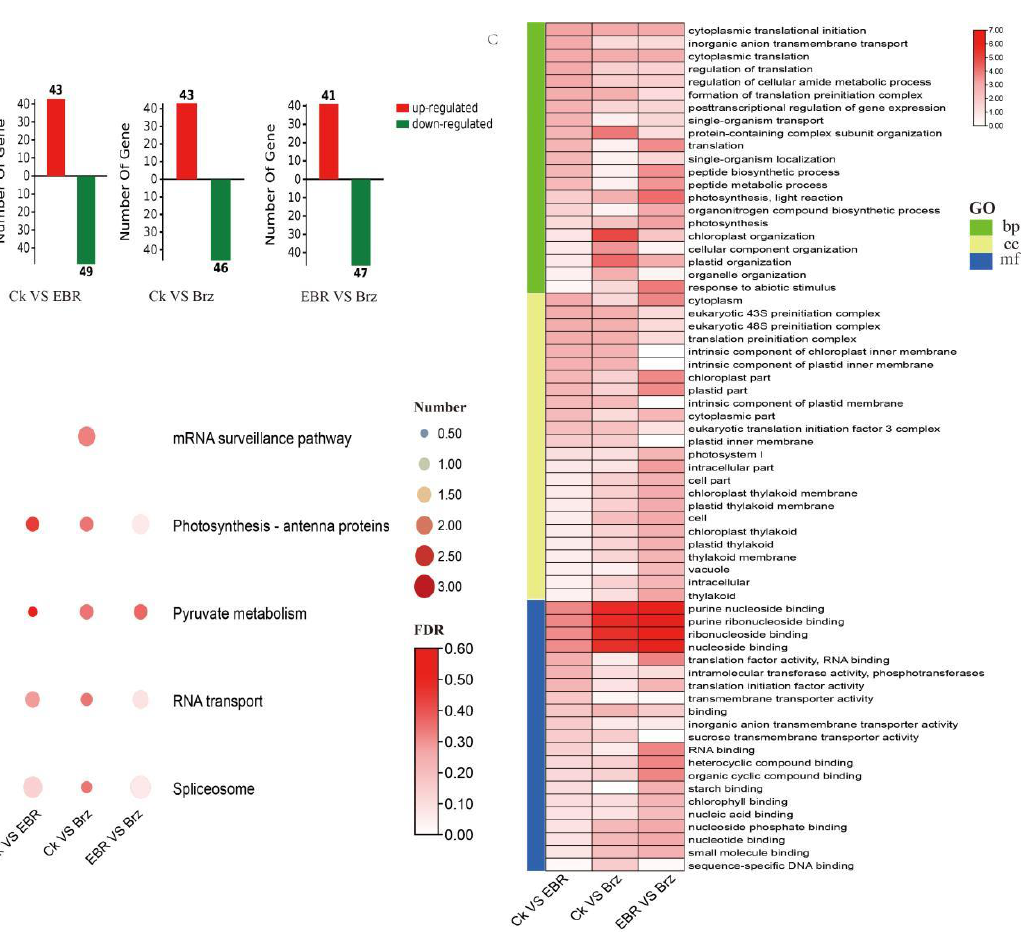
Figure 4. Enrichment analysis of the BR-responsive phosphoproteomic changes in maize leave. ( A ) The number of differentially expressed proteins was analyzed statistically. ( B ) KEGG enrichment analysis of differentially expressed proteins presented as a heat map. ( C ) GO enrichment analysis of differentially expressed proteins as a heat map.